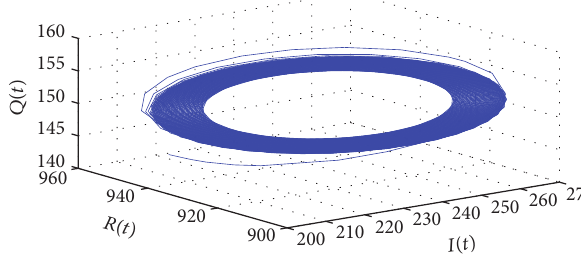
Figure 1: The projection of the phase portrait of system (69) in (𝑆,𝐸, 𝑉) -space with 𝜏 = 3.605 . 1